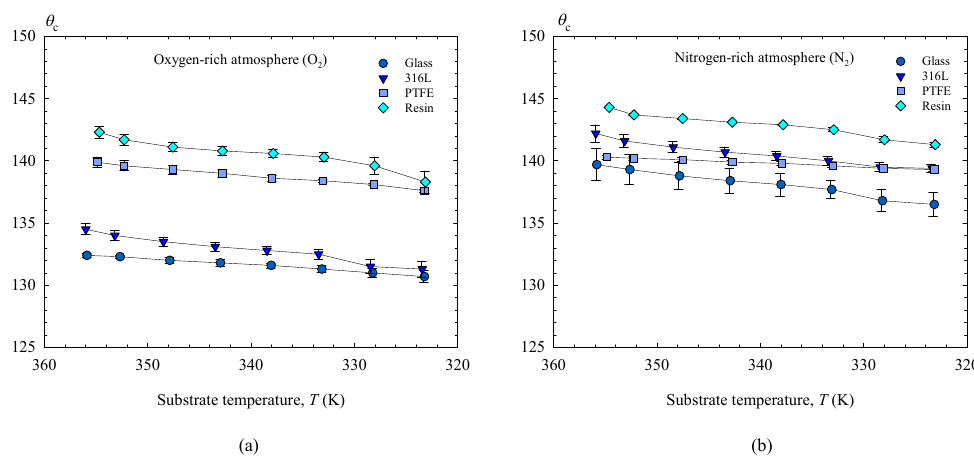
Figure 13. Contact angles ( θ c ) of Field’s metal as function of substrate temperature, for different types of substrate (AISI 316L, Resin, PTFE, Glass): ( a ) O 2 . ( b ) N 2 .